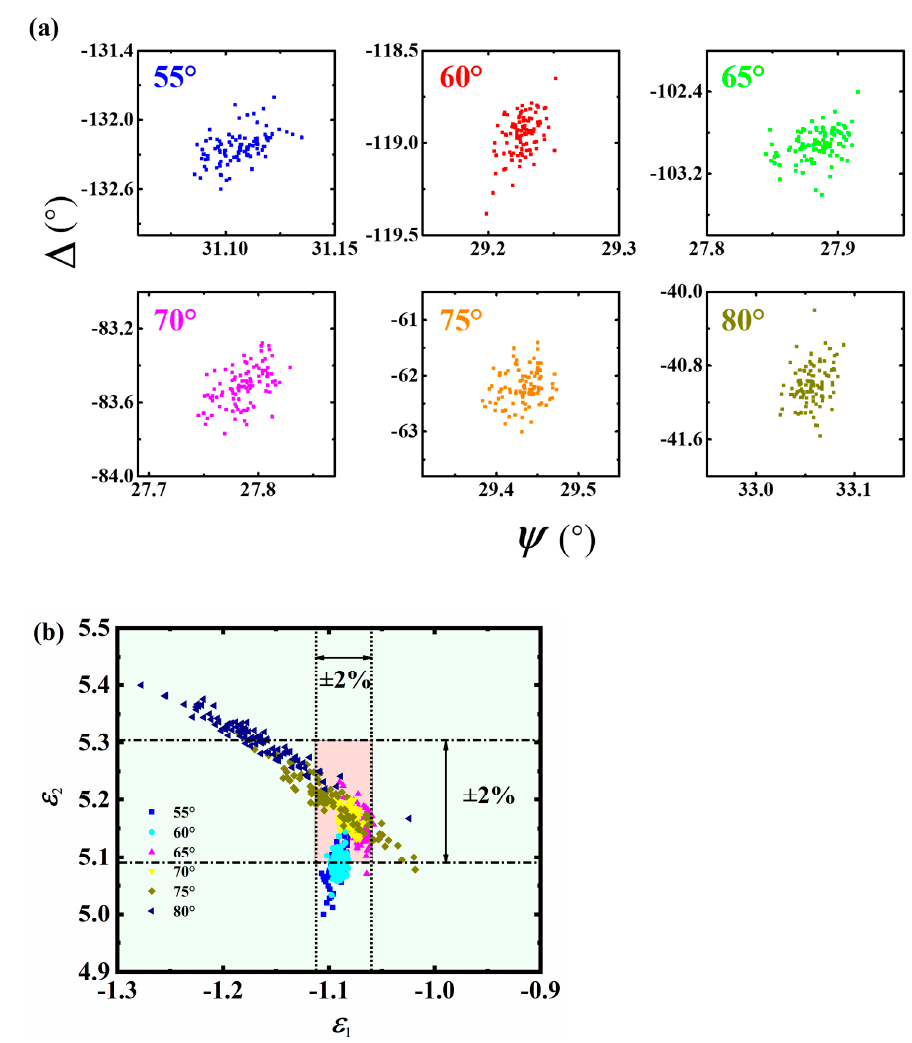
Figure 5. Distribution of the 100 ( a ) repeatedly-measured ellipsometric parameters, and ( b ) deter- mined dielectric constants for six incident angles at a wavelength of 350 nm .